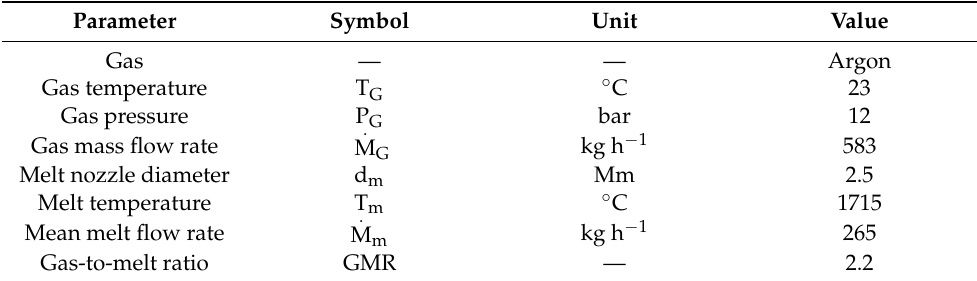
Table 1. The parameters used for atomization